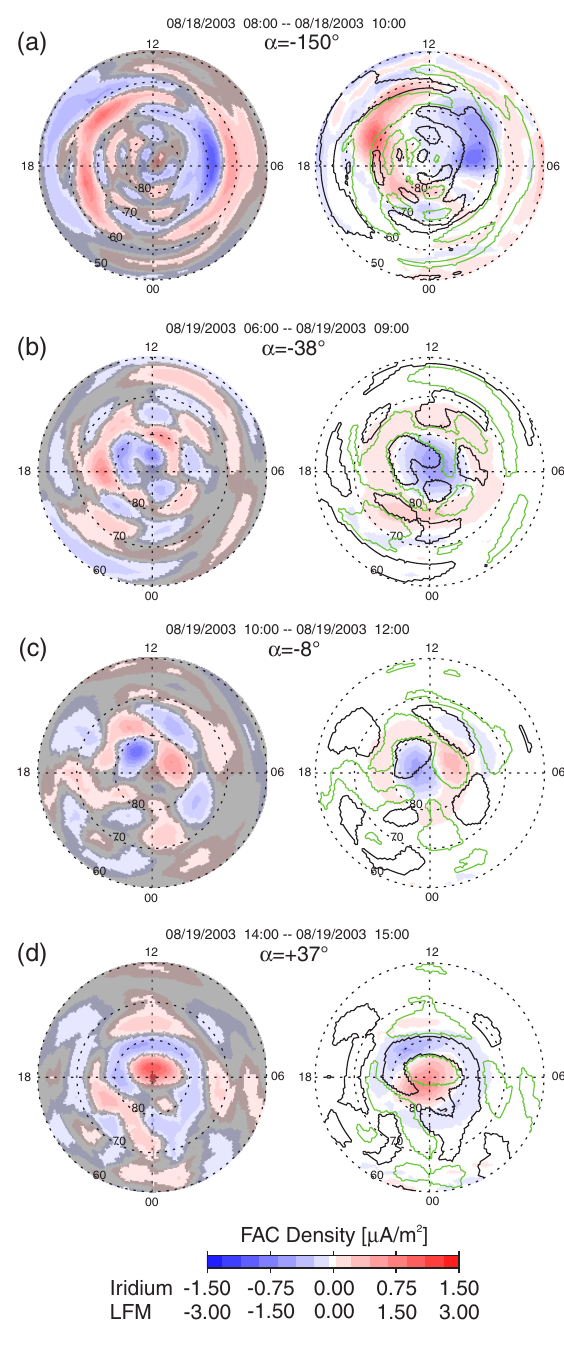
Fig. 2. Comparison of Birkeland current distributions (left panels) observed during the 17–19 August 2003 magnetic cloud with LFM simulations results (right panels). Downward and upward currents are represented by the colors blue and red,